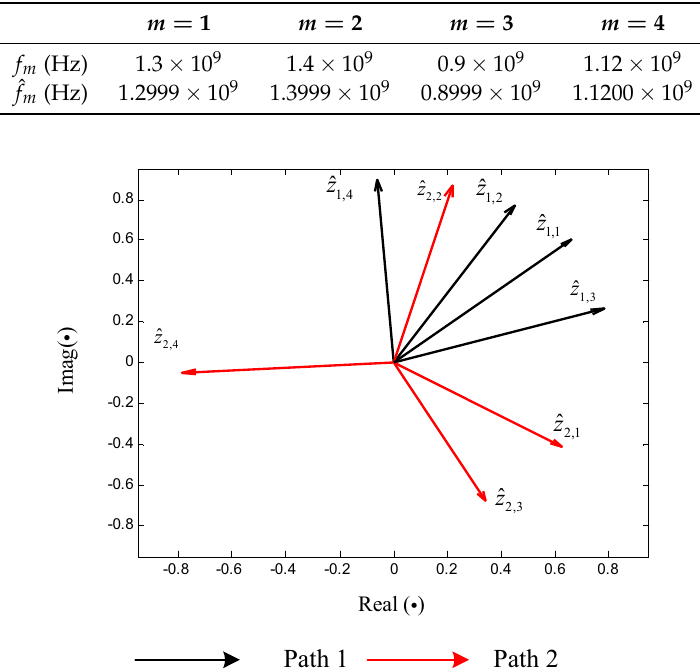
Table 4. Final results of frequency recovery.